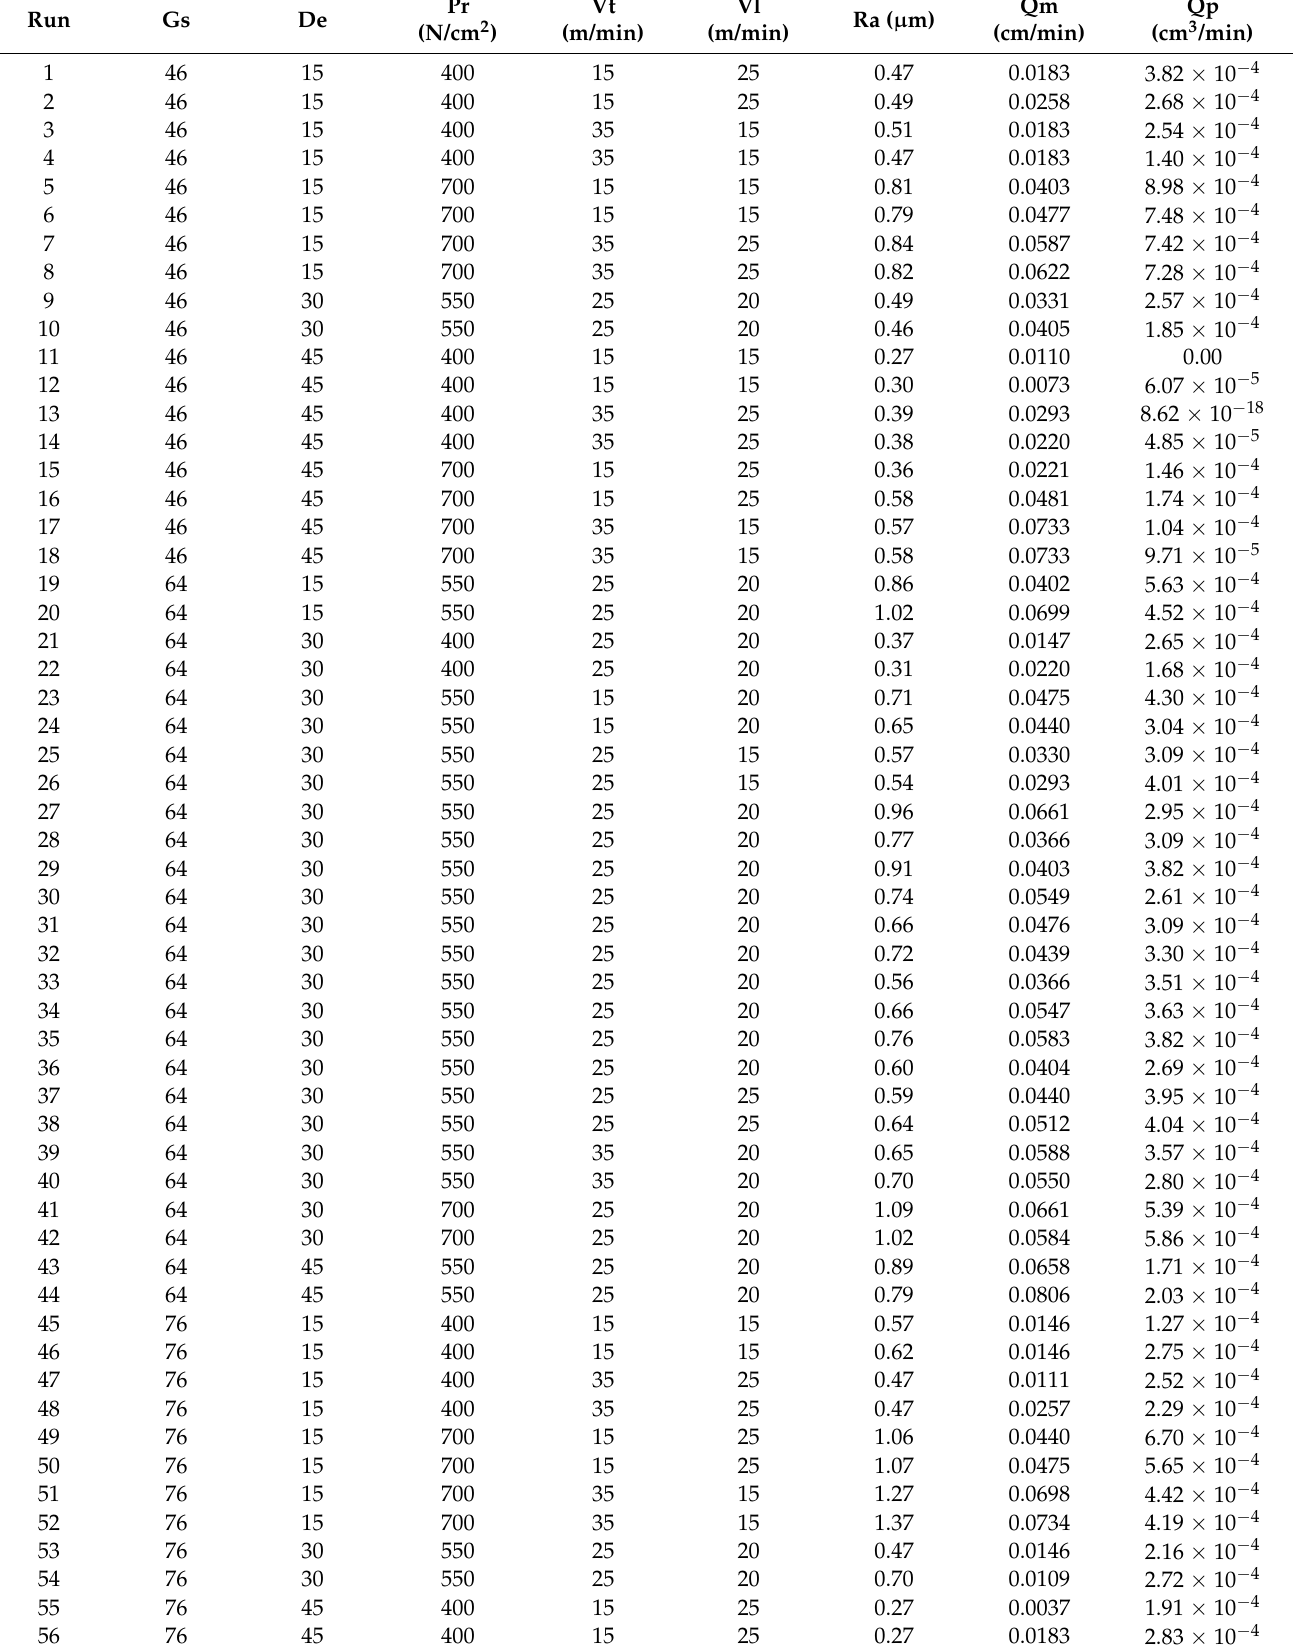
Table A2. Experimentation results in the semi-finish